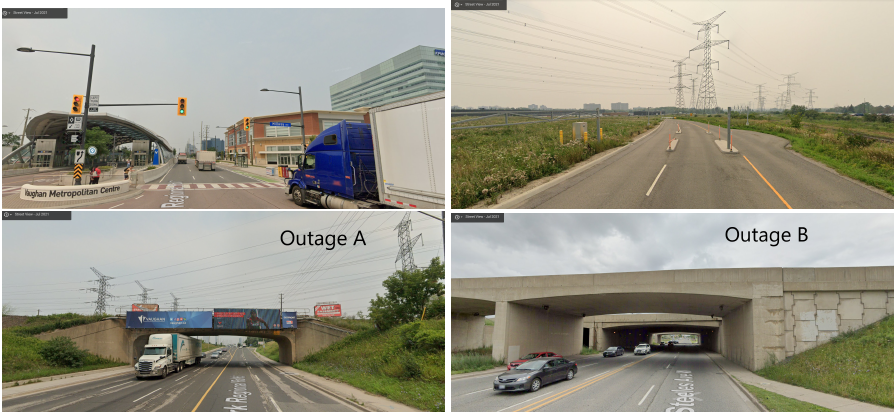
Figure 4. Google Street View of experimental